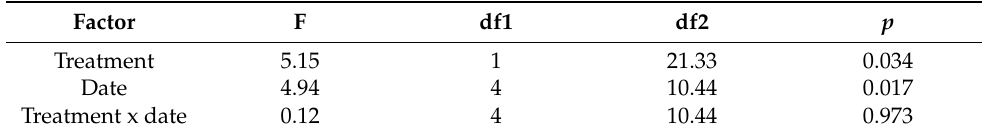
Table 2. Factor effects in the generalized linear mixed model carried out on mean number of ants counted on the